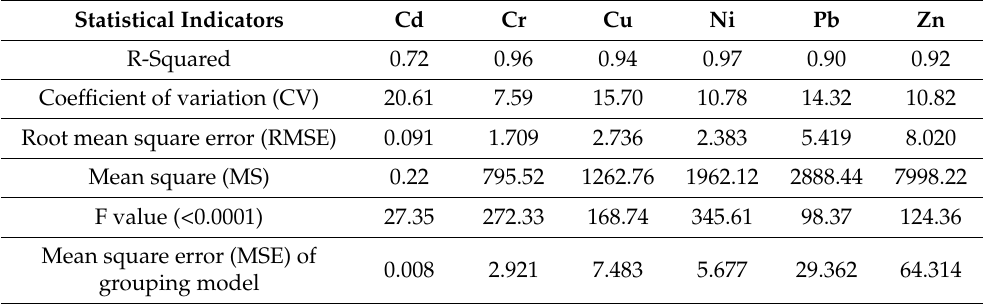
Table 1. The results of the statistics of the content of individual metal elements in the soil according to the variable altitude above sea